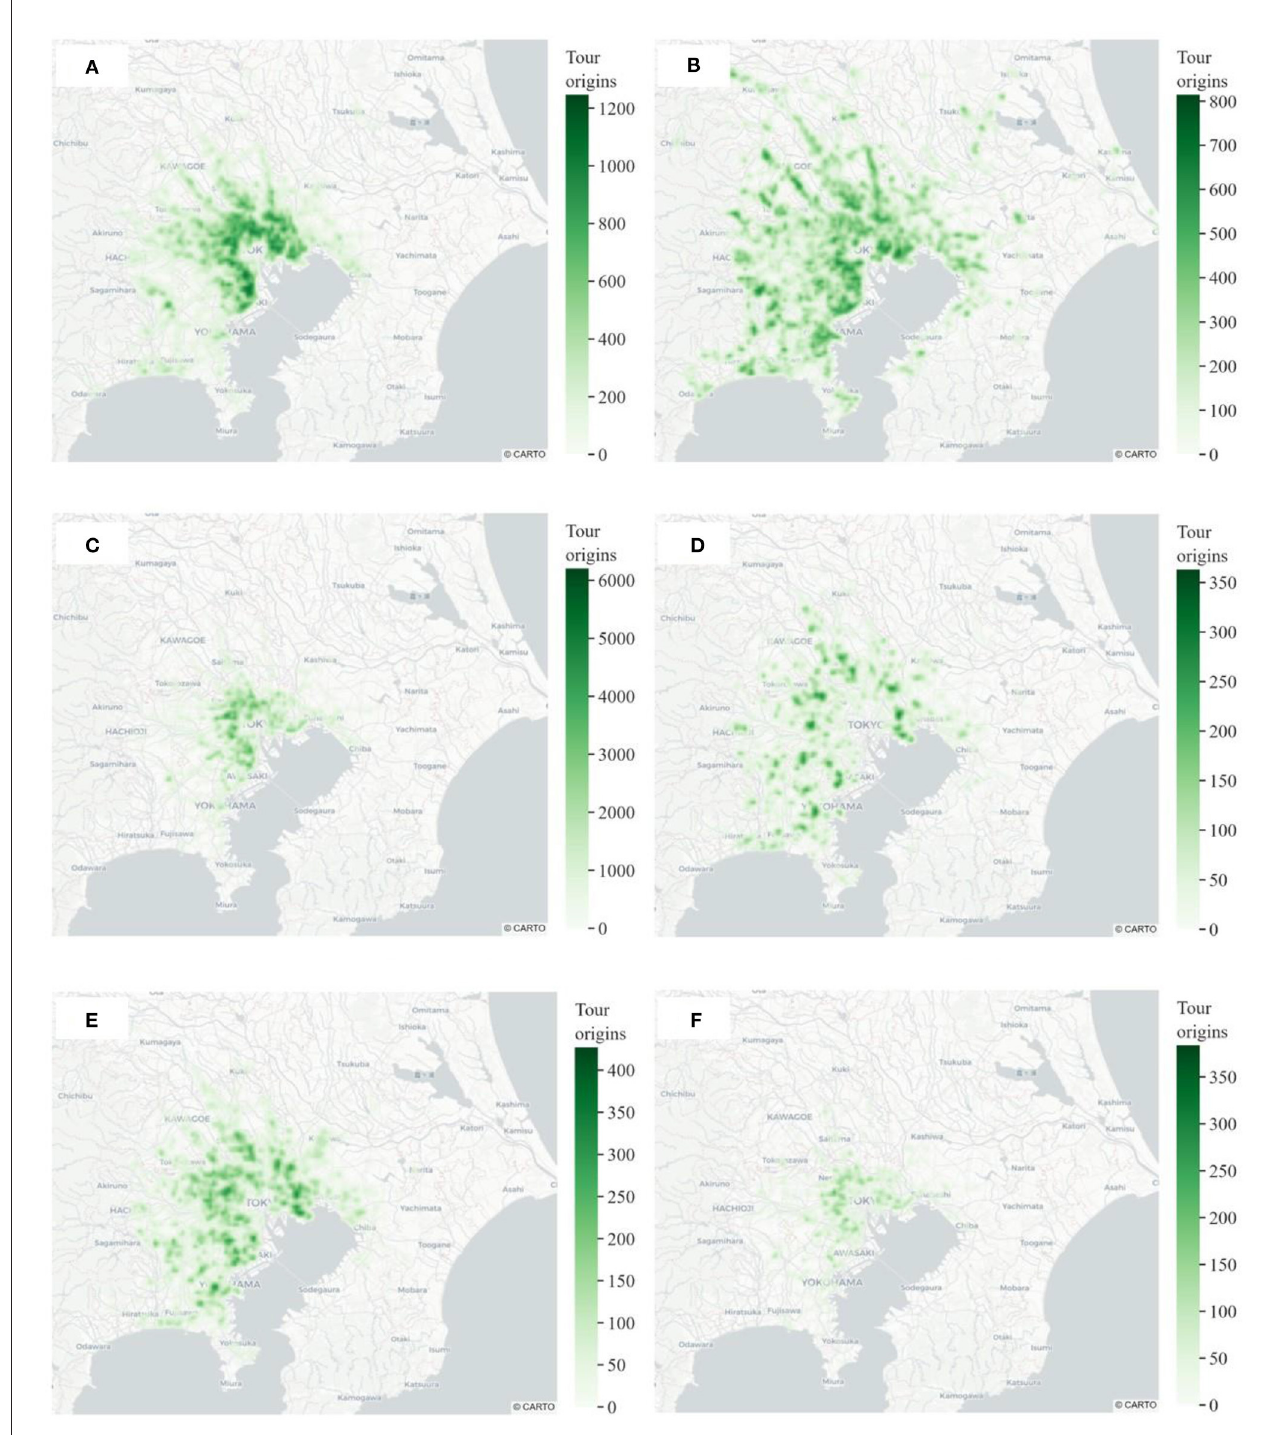
FIGURE 11 | |Tours’ origins by zone and transport mode sequence. (A) Transport modes: bicycle; bicycle, (B) transport modes: car; car, (C) transport modes: train; train, (D) transport modes: car; train; train; car, (E) transport modes: bicycle; train; train; bicycle, and (F) transport modes: train; bicycle; bicycle; train.